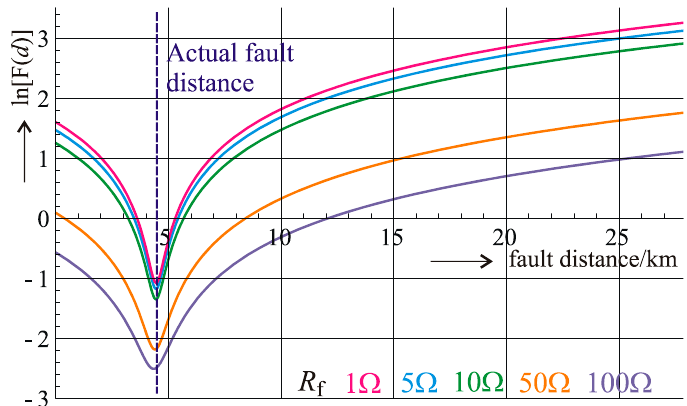
Figure 7 . Fault resistance impact on two-terminal fault location (the actual fault distance 4.49 km).